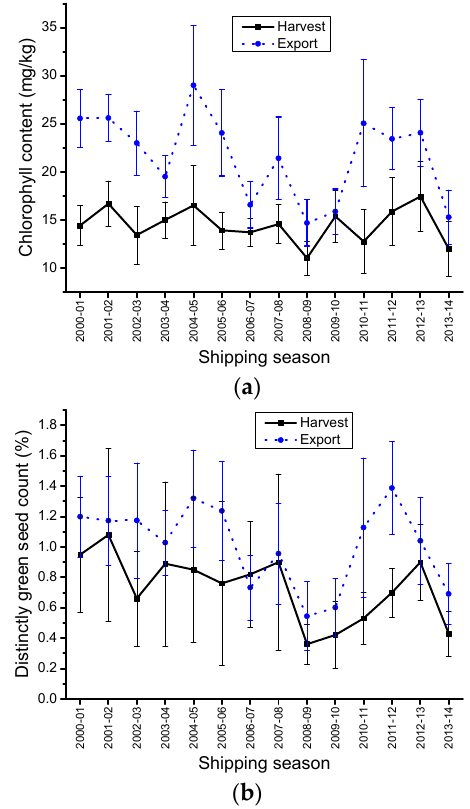
Figure 3. Chlorophyll content and green seed count averages, harvest (HSD) and export (ECD) samples of Canada No.1, Canola from 1 August 2000 to 31 July 2014. ( a ) Canola chlorophyll content averages; ( b ) Green seed count averages.